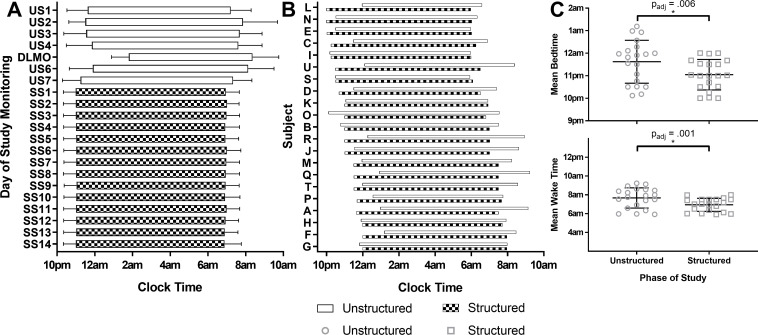
Sleep-wake timing throughout at-home sleep monitoring.A: Group level mean timing of each sleep period during at-home monitoring. US: Unstructured Sleep; DLMO: At-home DLMO assessment; SS: Structured Sleep. Each row shows group mean timing of one sleep episode; error bars show SD. B: Individual level mean timing of sleep period for each participant in Unstructured (white rectangles, top) vs. Structured (square patterned rectangles, bottom) Sleep, ordered from earliest to latest bedtime in Structured Sleep. C: Comparison of mean bedtime (top) and wake time (bottom) in Unstructured (circles) vs Structured (squares) Sleep. Black lines show mean and SD; symbols show individual data. padj: False Discovery Rate adjusted p-value; *Statistically significant result.